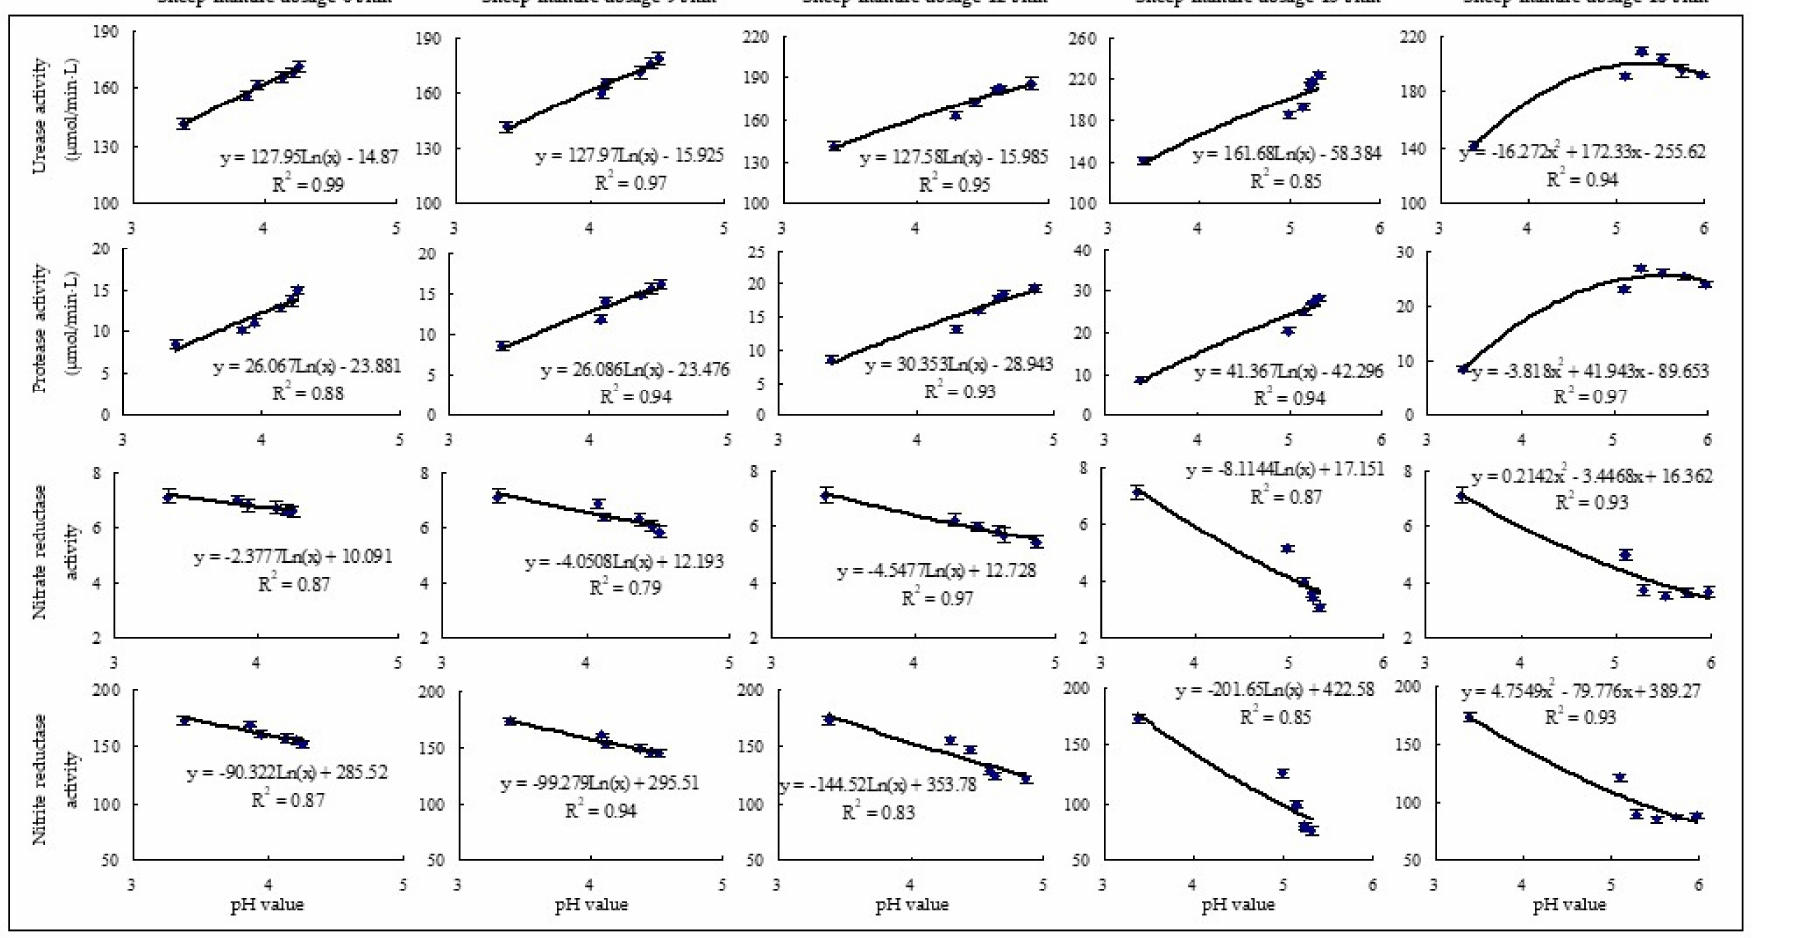
Figure 8. Effects of pH value on soil enzyme activity in tea plantation after a continuous use of sheep manure fertilizer with different